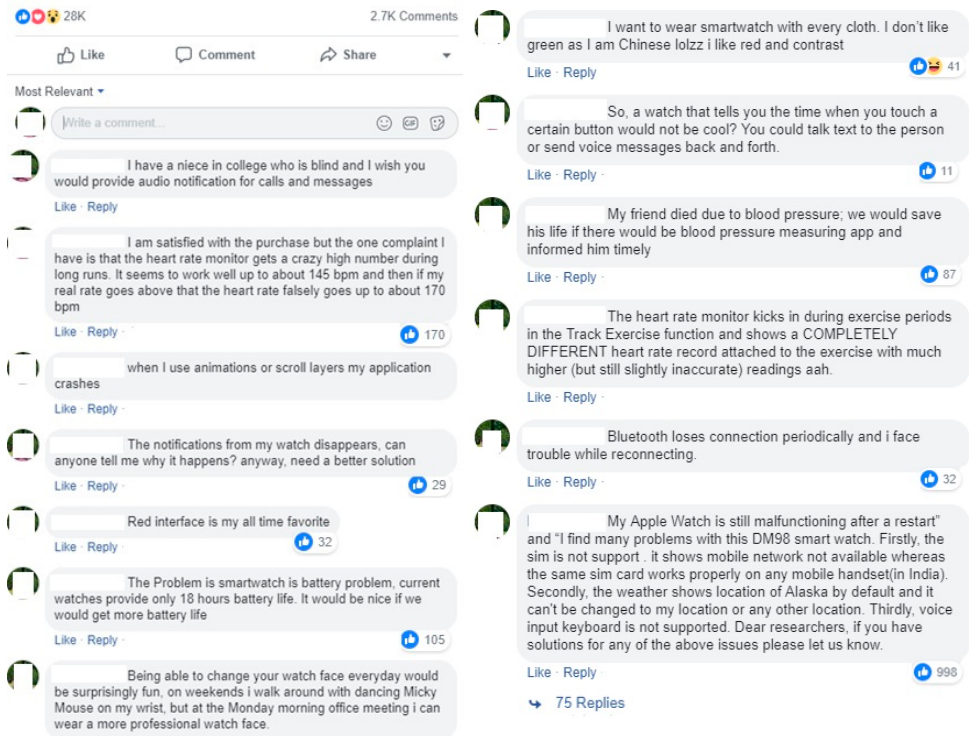
Figure 10. Sample Corpus with discussion and comment likes.